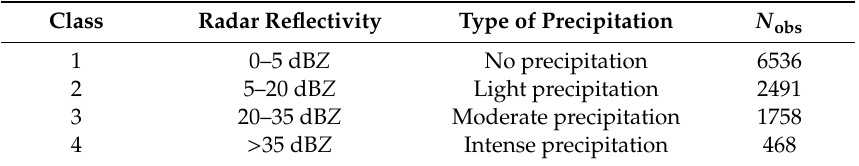
Table 2. Description of di ff erent precipitation intensities used in this study. The number